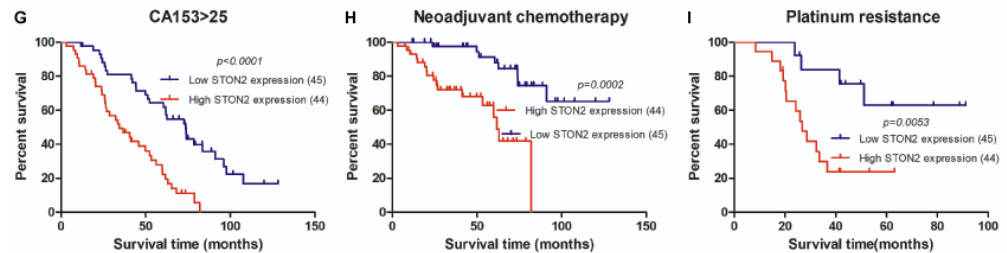
Figure 4. Kaplan–Meier curves of the univariate analysis data (log-rank test) showing the ( A ) overall survival (OS) and ( B ) disease-free survival (DFS) in patients with high versus low STON2 expression. The Kaplan–Meier curves of the univariate analysis data (log-rank test) of patients with high versus low STON2 expression. ( C ) OS of patients with intraperitoneal metastasis. ( D ) OS of patients with intestinal metastasis. ( E ) OS of patients with intraperitoneal recurrence. ( F ) OS of patients with ascites containing tumor cells (+). ( G ) OS of patients with CA153 > 25 U/mL. ( H ) OS of patients who received neoadjuvant chemotherapy. ( I ) OS of patients who exhibited platinum resistance. Table 4. Cox regression univariate and multivariate analyses of prognostic factors in epithelial ovarian cancer.